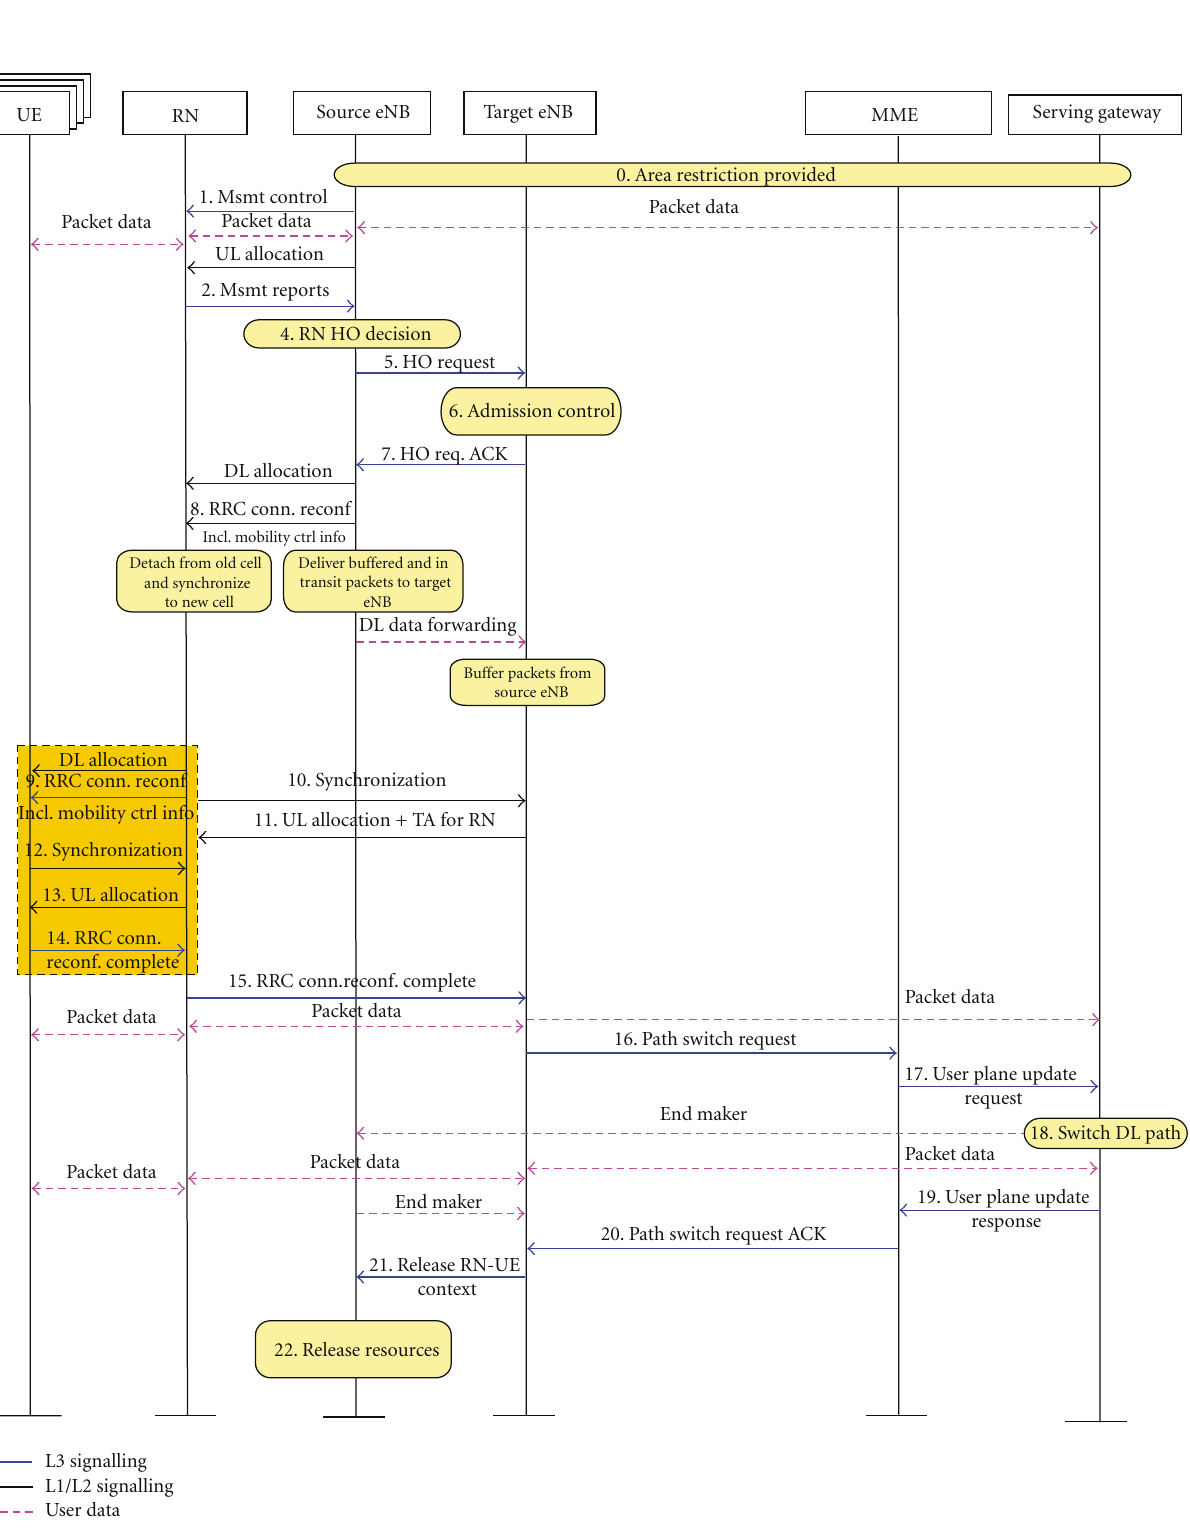
Figure 3: Handover of an RN and all its associated UEs in an LTE network that supports dynamic RN